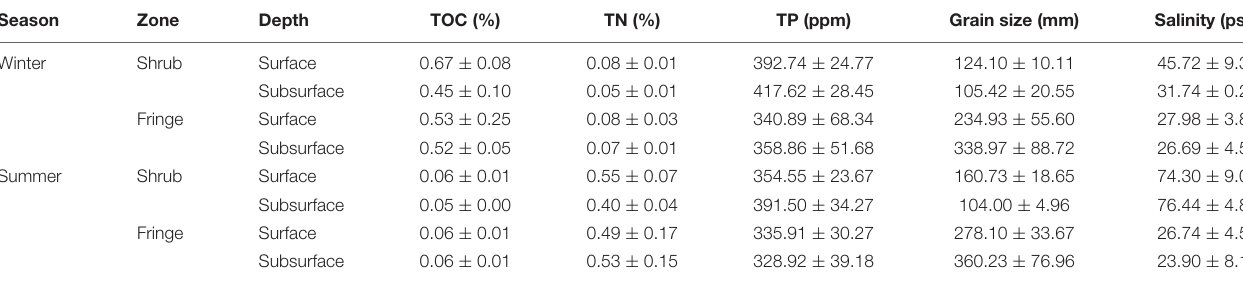
FIGURE 7 | Comparison of differentially abundant phyla between the fringe and the shrub. Negative values mean a decrease, and positive values show an increase of the indicated phylum in the shrub relative to the fringe. Only significant phyla are shown (p-adjusted < 0.05). The height of the bar indicates the level of change between the zones and the error bars show the standard deviation of the test statistic. TABLE 2 | Summary table of the measured soil parameters from both seasons and different locations in the mangrove